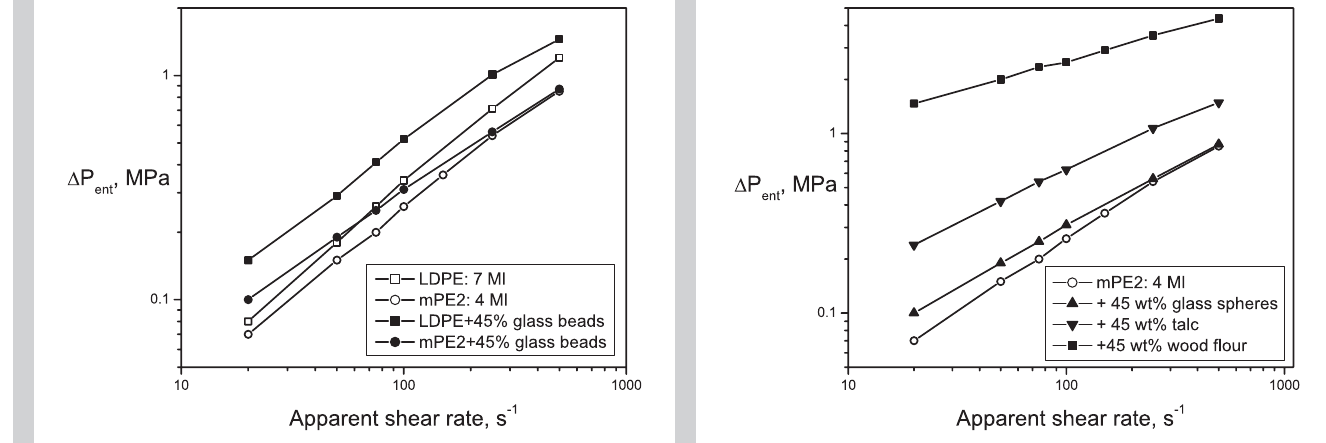
Figure 10 (left): Entrance pressure loss as a function of the apparent shear rate of the high melt index polyethylene/glass spheres composites. Figure 11: Entrance pressure loss as a function of the apparent shear rate of mPE2 contain- ing different fillers. Table 2: Comparison of the relative entrance pressure loss of PE containing different fillers at 45 wt% loading; appar- ent shear rate 100 s -1